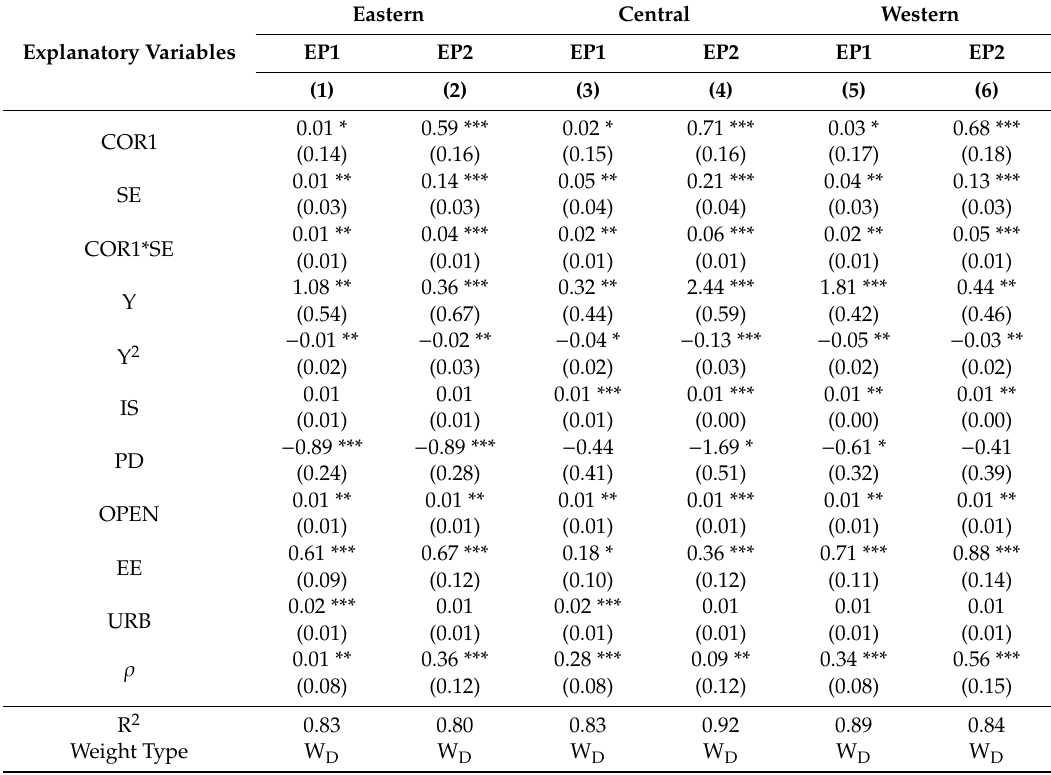
Table 5. Empirical results of di ff erent